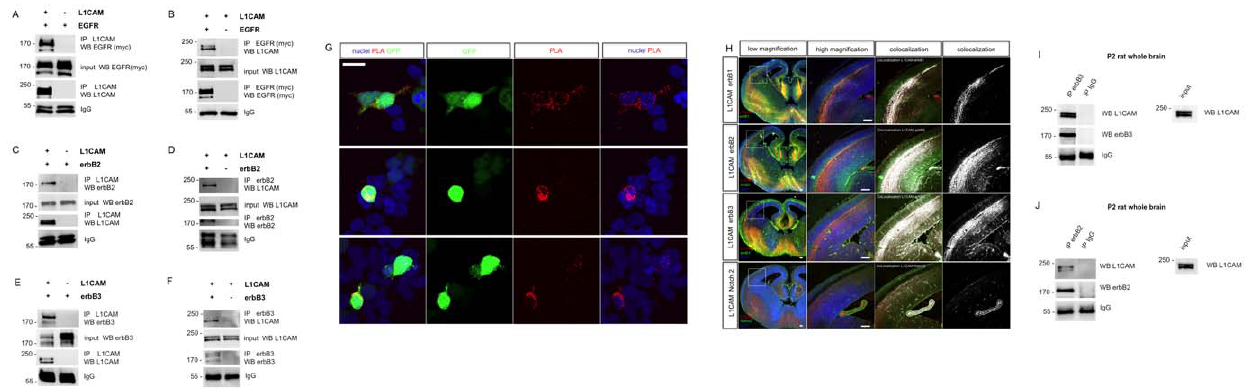
Figure 1. Physical interaction of L1CAM with erbB receptors. a ) L1CAM co-immunoprecipitates with erbB1 (EGFR): a pcDNA3 plasmid containing the cDNA encoding for human L1CAM and the pcDNA6A-EGFR construct were transiently co-transfected into the HEK293 cells. 48 h later cells were homogenized and L1CAM immunoprecipitated (IP). Immunoprecipitates were resolved by SDS-PAGE and blotted with anti-myc antibody to detect EGFR. As is shown, EGFR was pulled down only in L1CAM expressing cells. EGFR expression was similar in both extracts (input). Immunoblot with anti-L1CAM shows that this protein was correctly immunoprecipitated. b ) Reverse co-immunoprecipitation. IP with anti-myc antibody pulls down L1CAM only in EGFR transfected cells. L1CAM expression was similar in both extracts (input). Immunoblot with anti-myc shows that the